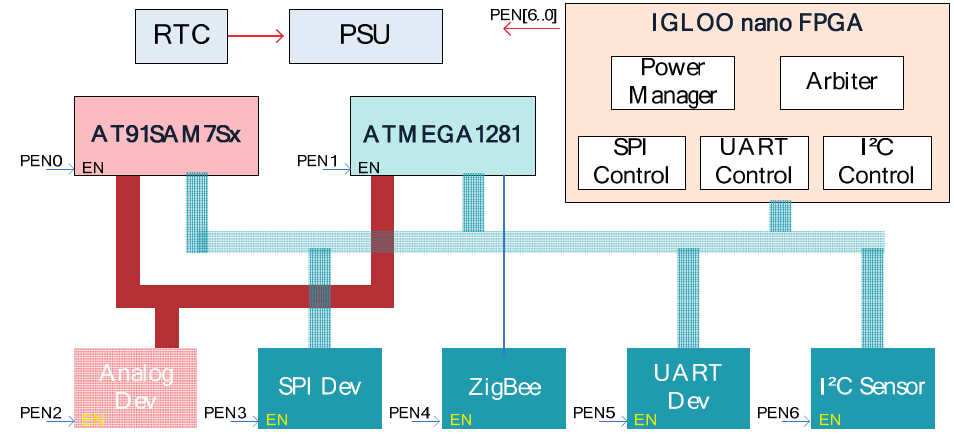
Figure 20. Circuit diagram of the multi-core EMWSN node. The working modes of different microcontrollers can be configured.